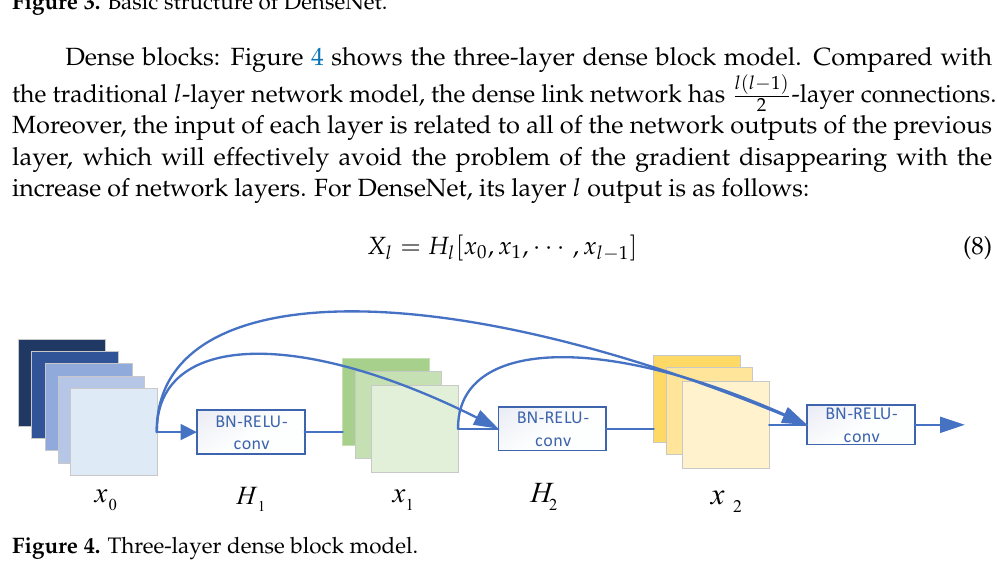
Figure 3. Basic structure of DenseNet.